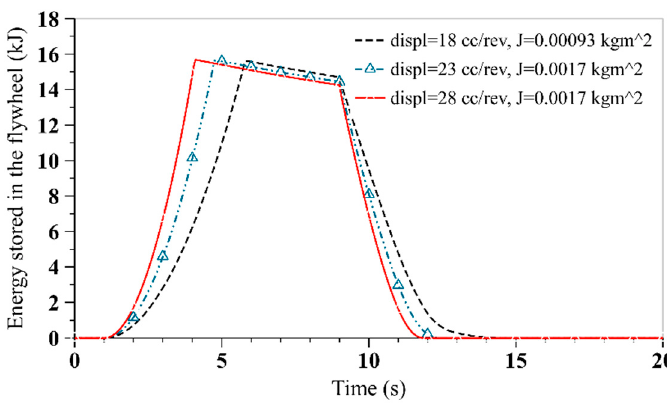
Figure 22. Rotational speeds of the flywheel at different PM displacements.